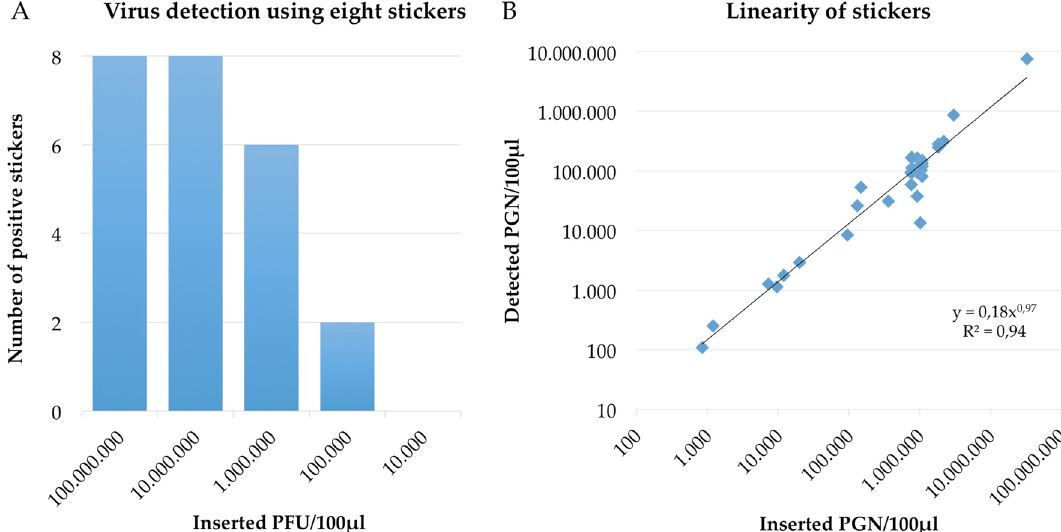
Figure 2. ( A ) The number of positive findings of eight sticker values and swab values determined by plaque assay from four independent experiments performed in duplicate. Virus titer concentrations ranging from 10 8 to 10 4 were used for artificial, direct contamination of paper-based stickers and routine cotton swabs. ( B ) The quantification of artificially contaminated plain-paper stickers (n = 32) with virus P100. The sampling material was contaminated with known virus titers ranging from 10 8 to 10 2 PGN/100 µL to cover a broad recovery range. The x-axis plots the inserted quantity of viral genomic matter (PGN/100 µL) and the y-axis plots the recovered viral genomic matter from respective sampling